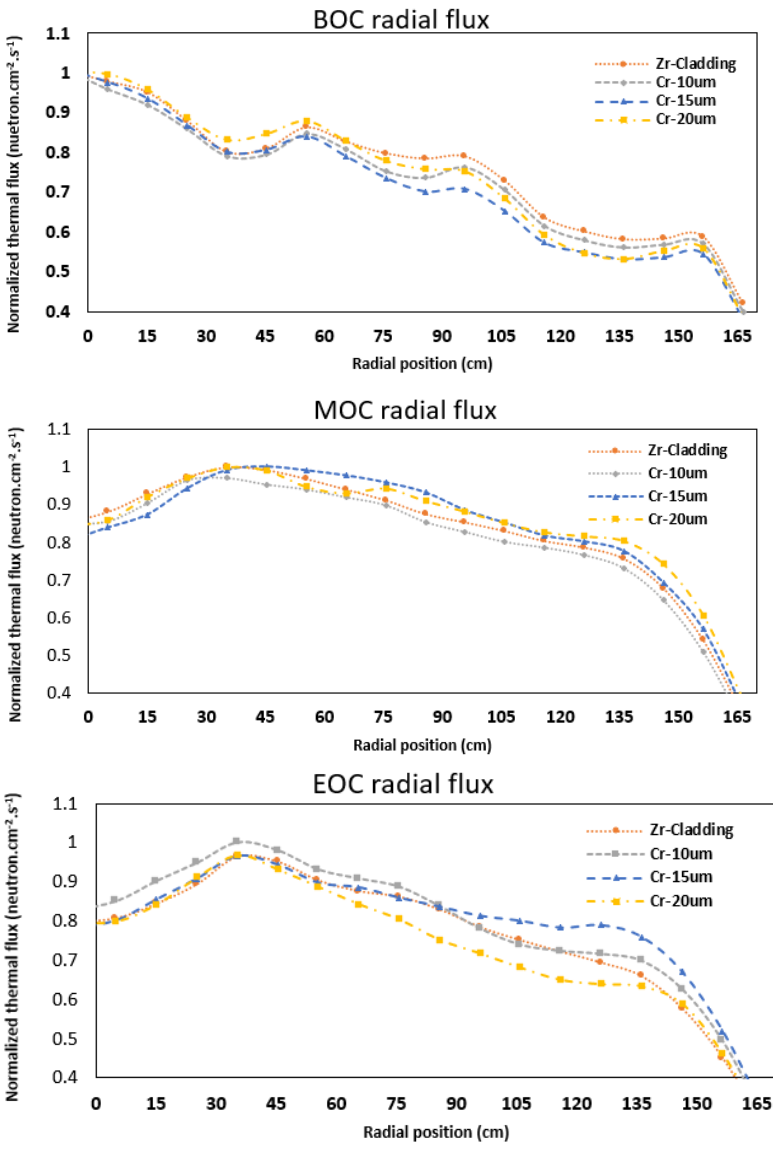
Figure 13. Radial neutron fluxes across the APR-1400 reactor core.